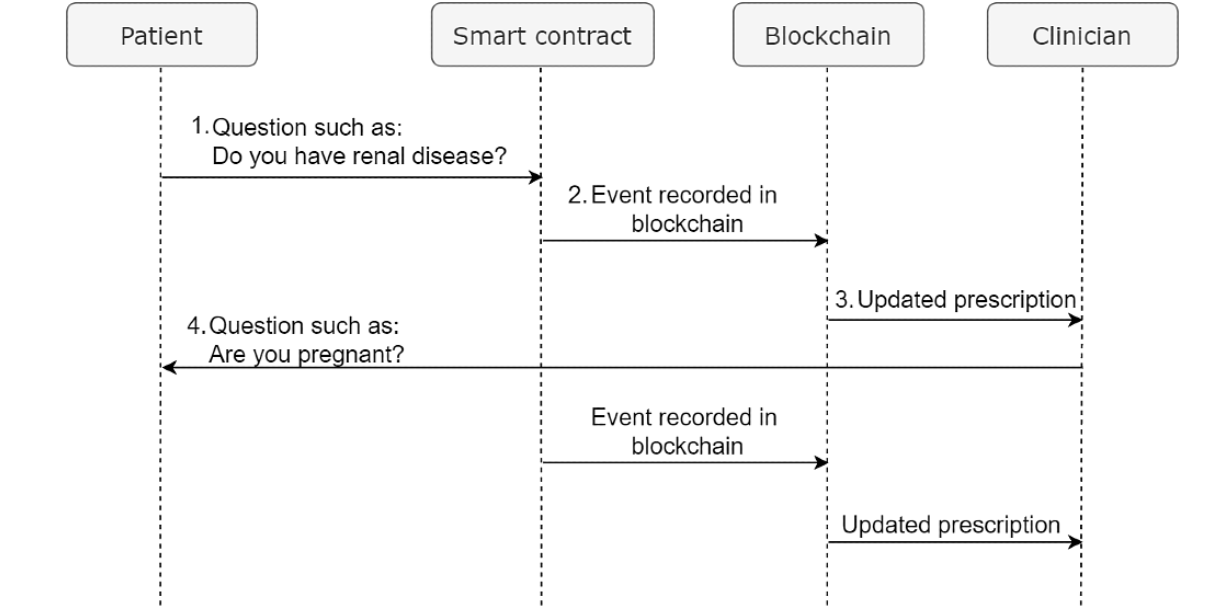
Figure 7. Workflow for involving a patient in the decision-making